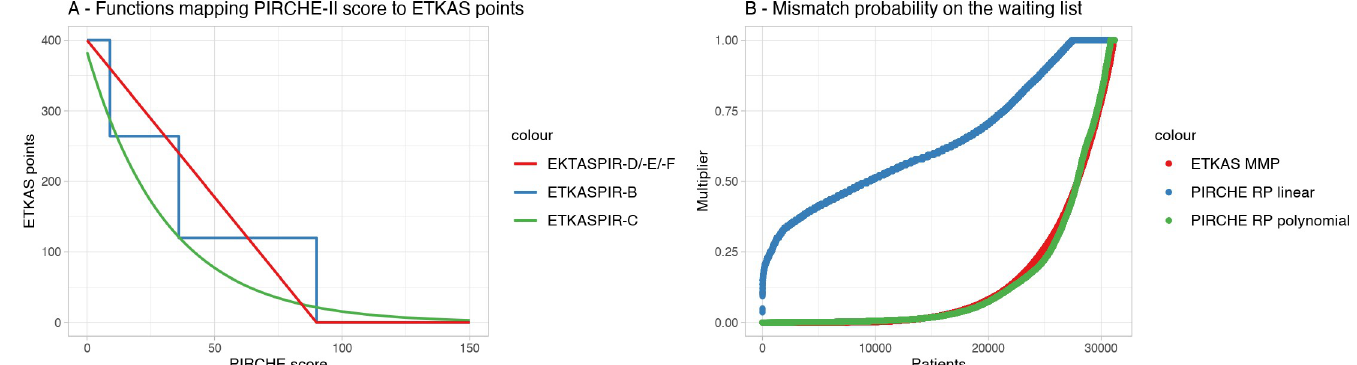
Fig 3. Match point distributions. (A) Graphical representation of the distribution of the 400 points for match grade in the PIRCHE-modified models ETKASPIR-B, -C, -D, -E, and -F. (B) Distribution of ETKAS points for HLA MMP on the bootstrapped waiting lists (red curve) shows a benefit for relatively few patients with rare genotypes. Unconverted, the PIRCHE-II risk profile (capped at PIRCHE-II weighted median of 200) assigns more points to average genotypes (blue curve), requiring fitting a polynomial (green curve) to match the regular ETKAS